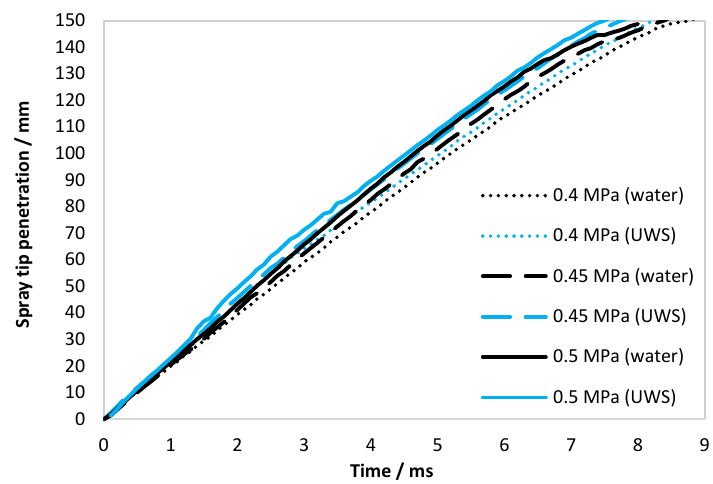
( d ) Figure 2. In-injector flow characteristics: ( a ) static mass flow rate; ( b ) static volumetric flow rate; ( c ) Reynolds number; ( d ) Weber number (referred to gas).